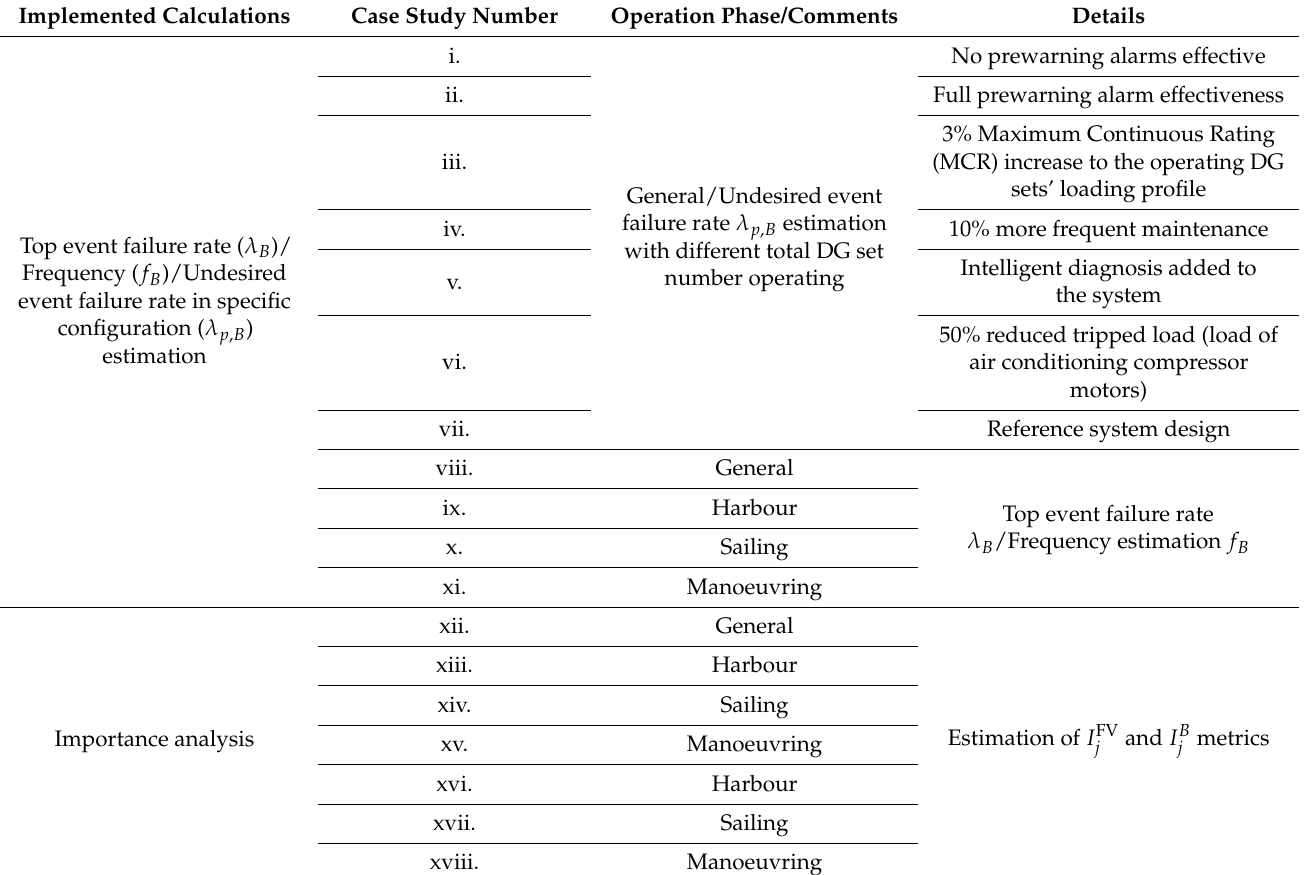
Table 2. Case studies’